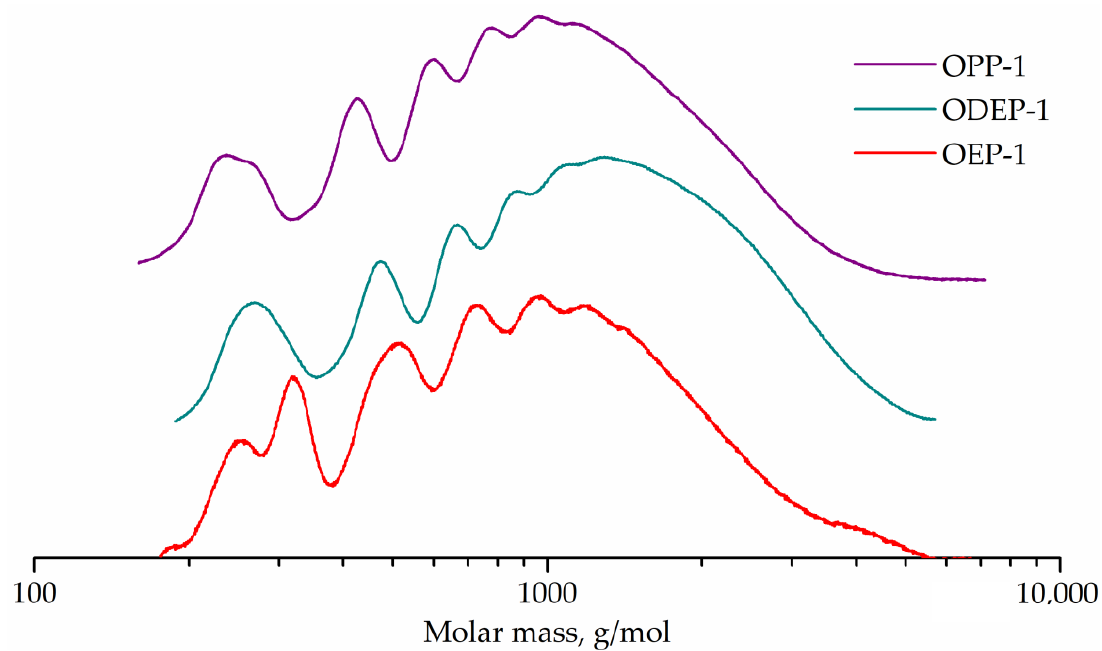
Figure 5. GPC curves of OEP-1, ODEP-1, and OPP-1 samples.